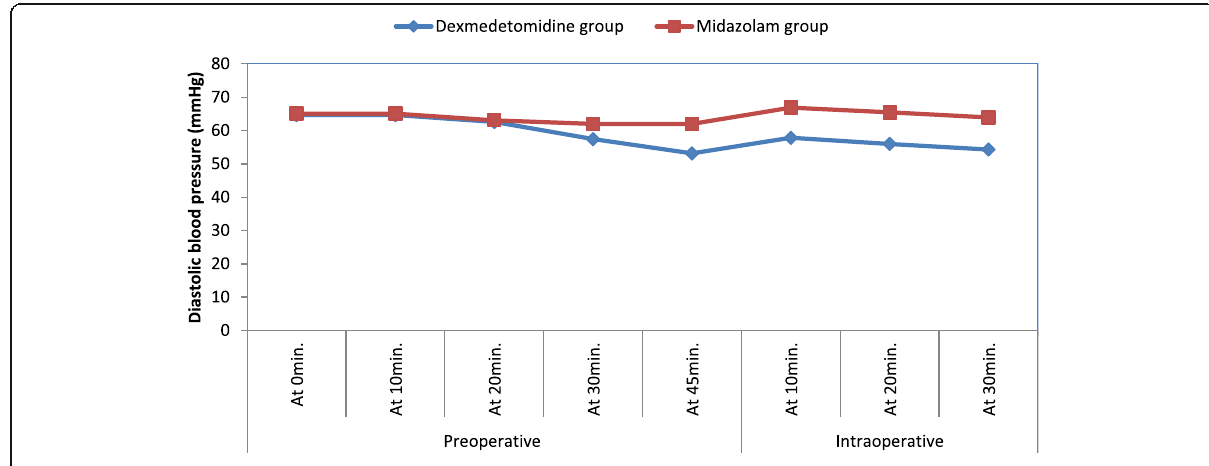
Fig. 3 Comparison between group D and group M regarding diastolic blood pressure. Data are presented as mean (±SD)